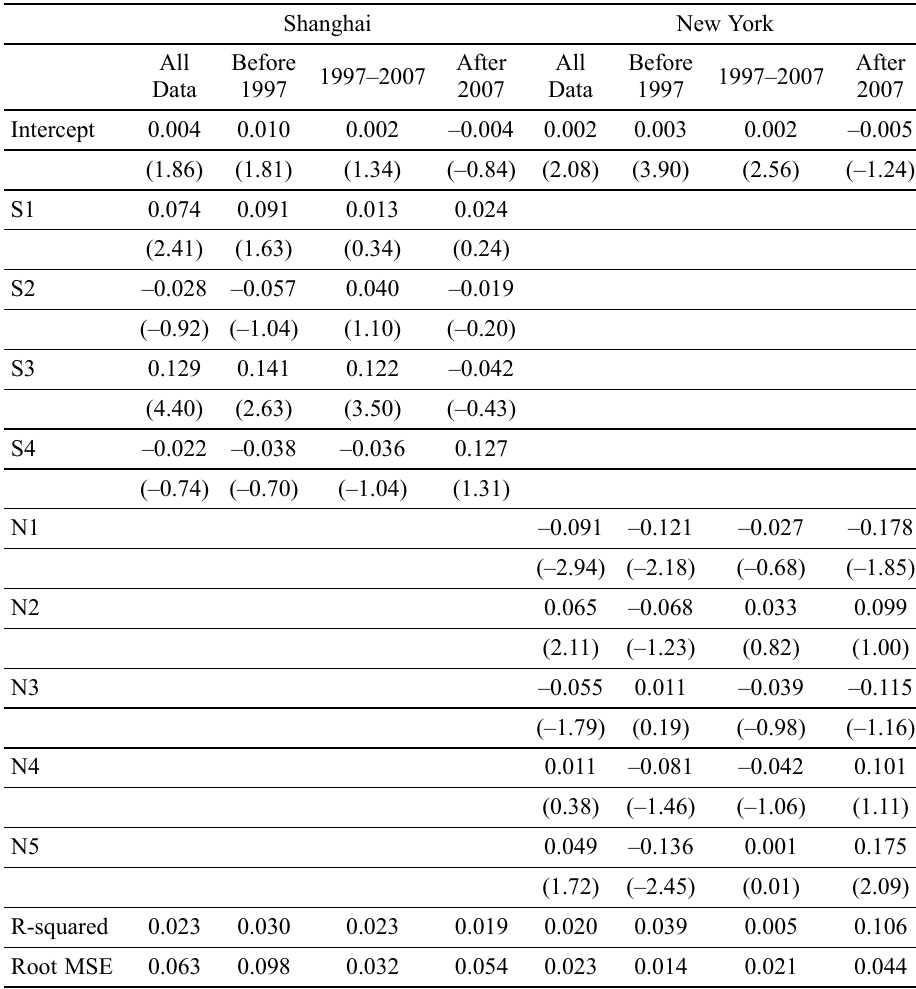
Table 8. Auto regressions of volatility of Shanghai and New York stock prices The table presents the auto regressions of the volatility of return of shanghai and New York stock prices in total sample and three subsamples: before 1997, after 1997 and before 2007, and after 2007. The rate of return is calculated as the change in the natural logarithm of the price index in a given period. The volatility of returns is calculated as the absolute value of the change in the natural logarithm of the price index in a given period. The price index is obtained from DataStream Equity Indices. S1 (S2, S3, S4) represents the one-lagged (two-lagged, three-lagged, four-lagged) of the rate of return of Shanghai stock prices while N1 (N2, N3, N4, N5) represents the one lagged (two-lagged, three-lagged, four-lagged, five-lagged) of the rate of return of New York stock prices. We also report R-squared and Root MSE. T -statistics are provided in the pa- rentheses. The sample period is from January 1991 to December